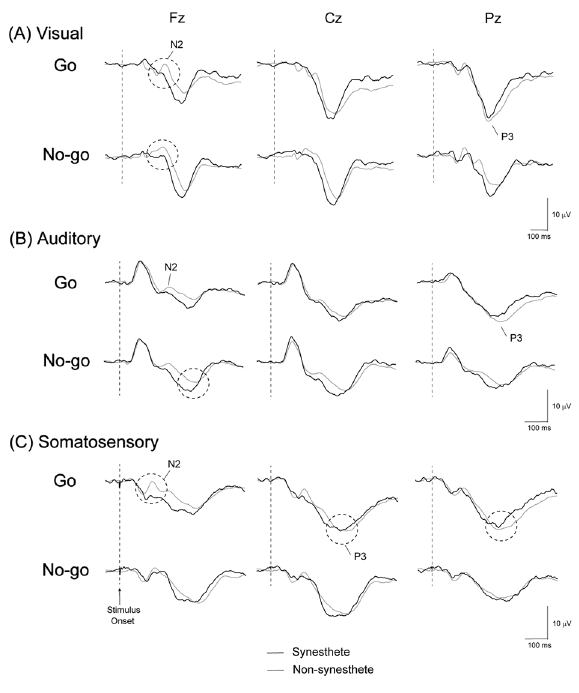
Figure 2. Grand-averaged ERP waveforms during ( A ) visual, ( B ) auditory, and ( C ) somatosensory Go/No-go paradigms. Black and grey lines indicate waveforms of synesthetes, and non-synesthetes, respectively.